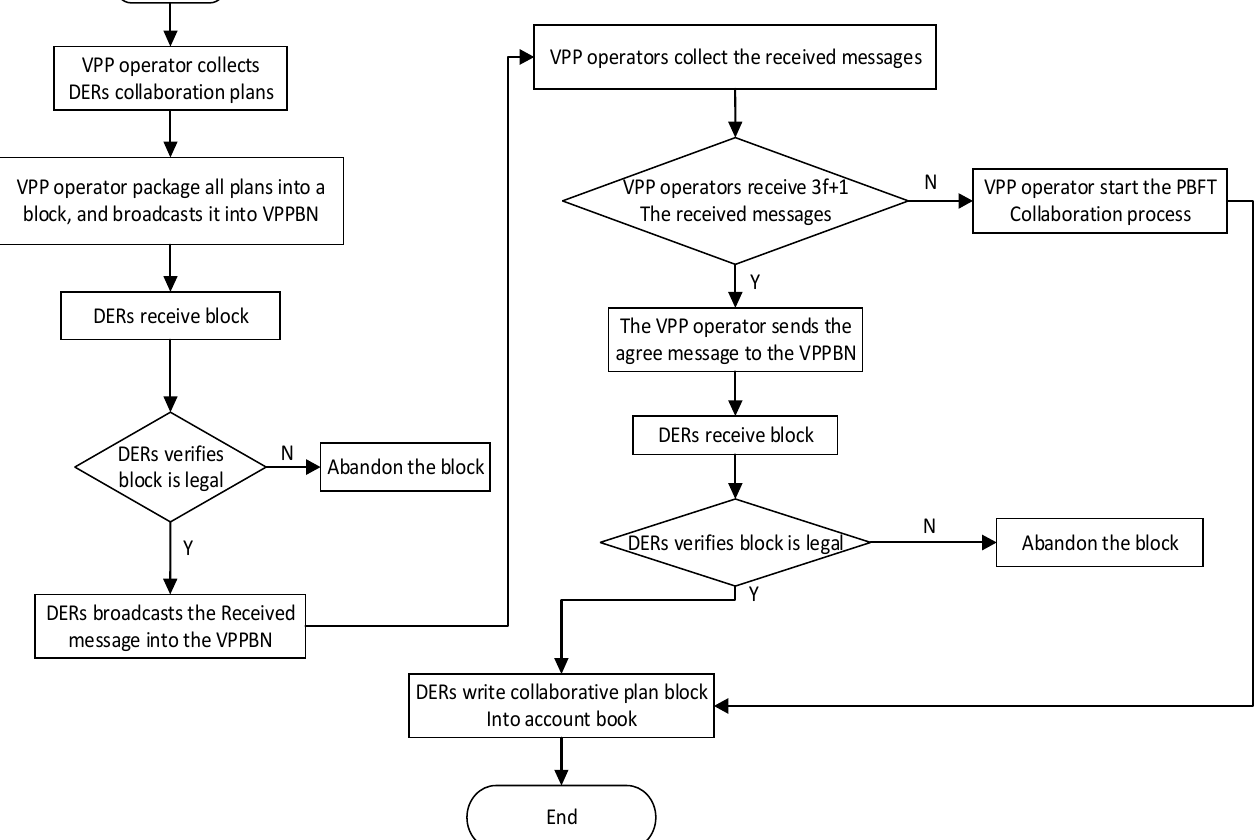
Figure 7. The flow chart of the fast consensus stage.